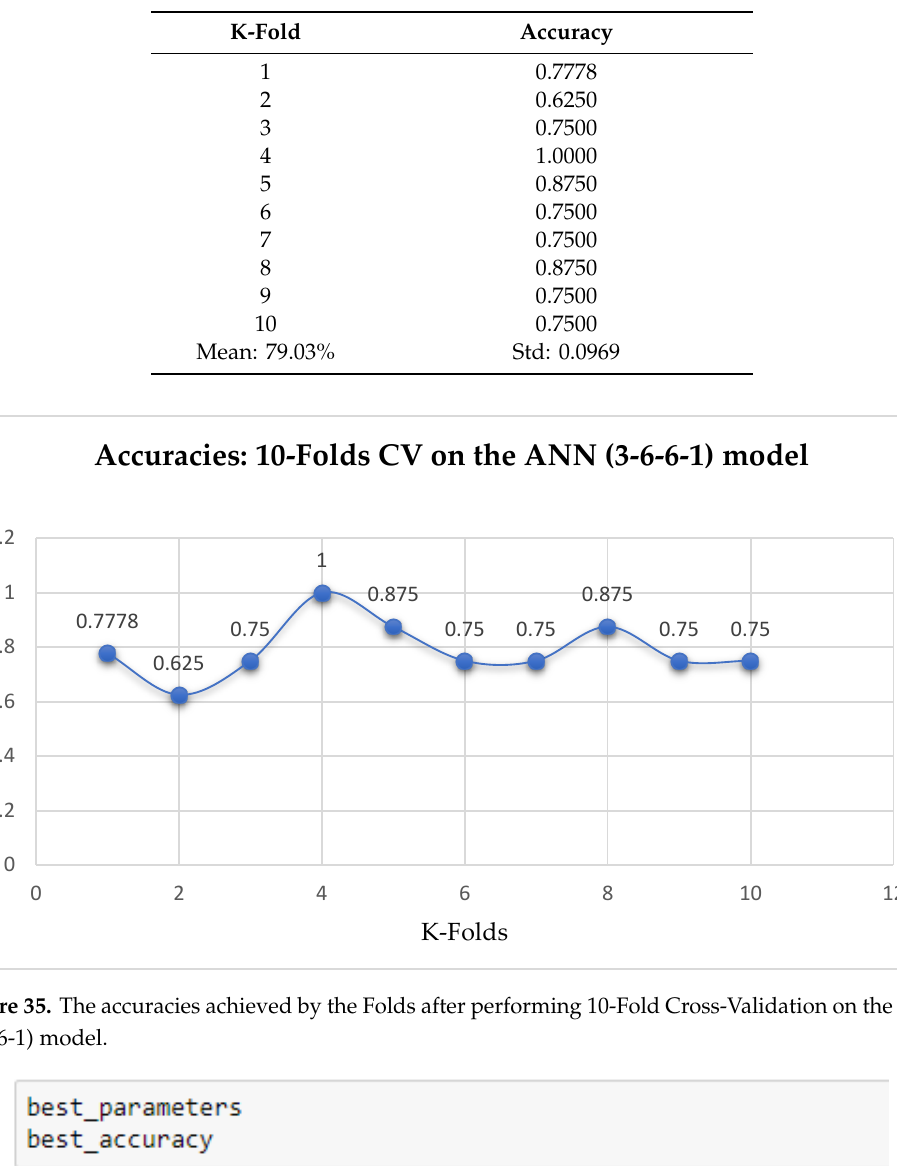
Table 12. Accuracies achieved by performing 10-Fold Cross-Validation on the ANN (3-6-6-1) model.